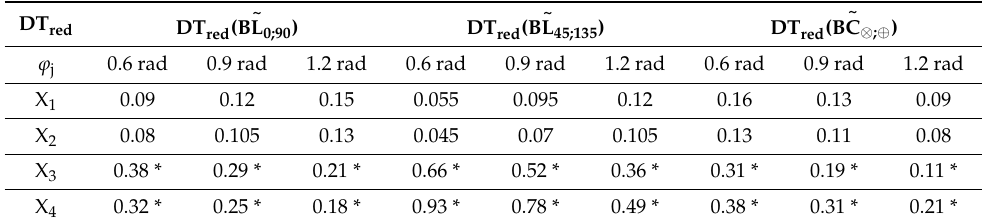
Table 1. The statistical structure parameters of layered diffuse tomograms of the fluctuation phase anisotropy of a polycrystalline blood film from healthy